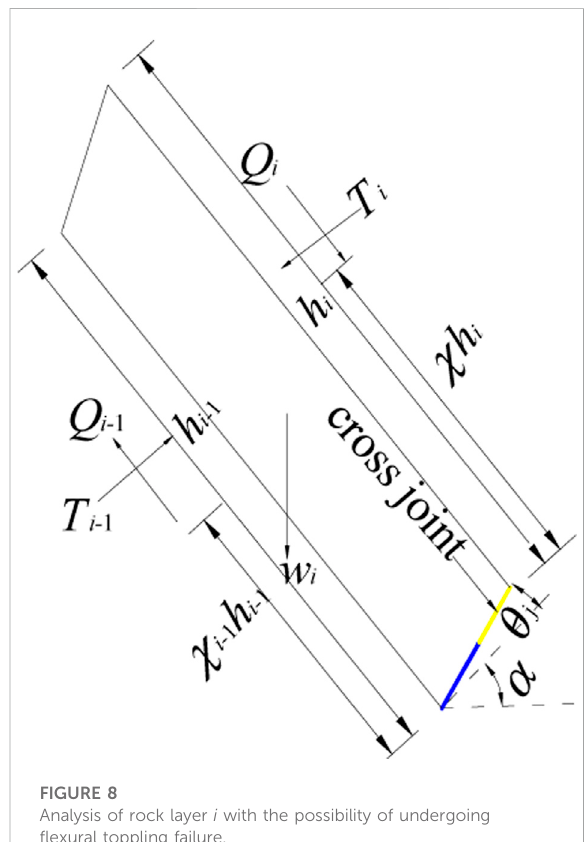
FIGURE 8 Analysis of rock layer i with the possibility of undergoing fl exural toppling